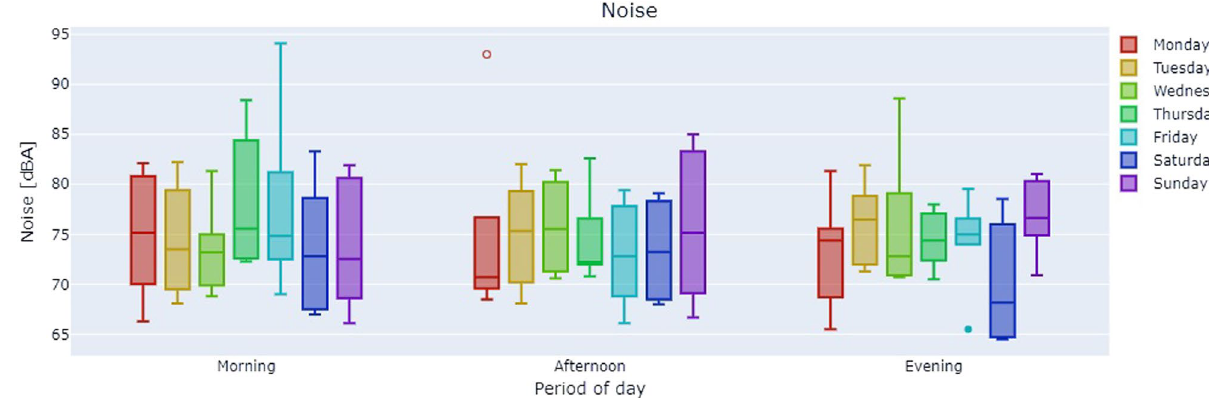
Fig. 6 Noise measurements distributions